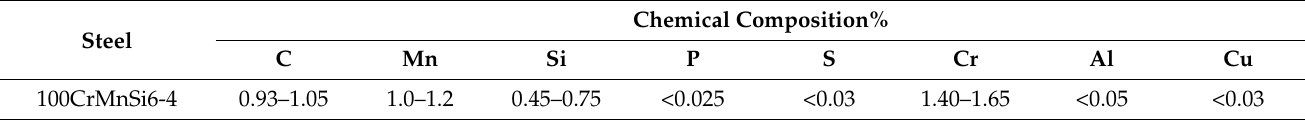
Figure 5. A workpiece being machined. Table 2. Chemical composition of bearing steel for a